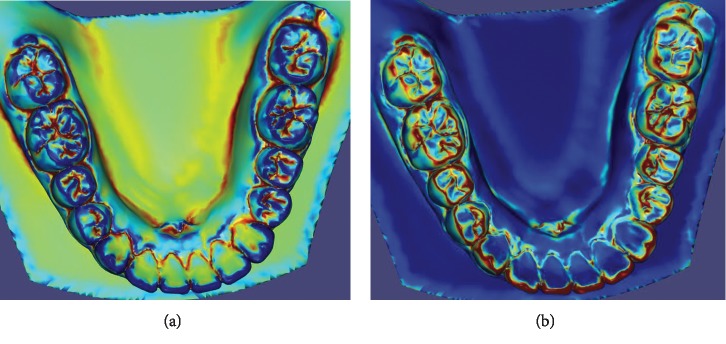
The visual result of (a) |kmax| − |kmin| and (b) |kmax|+|kmin|.